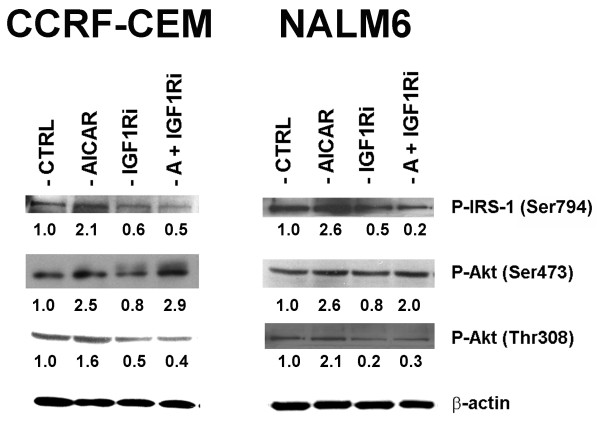
AICAR-induced AMPK activation phosphorylates Akt at Ser473 in a mechanism independent of IGF-1R/IRS-1 signaling in ALL cell lines. Western blot analysis of P-IRS-1 (Ser794), P-Akt (Ser473), and P-Akt (Thr308) in CCRF-CEM and NALM6 cells treated with 0.1% DMSO (CTRL), AICAR (200 μM), the IGF-1R tyrosine kinase inhibitor HNMPA(AM)3 (IGF1Ri, 10 μM), or both agents (A + IGF1Ri) and incubated for 24 h at 37°C. The levels of P-IRS-1 and P-Akt were normalized to β-actin (loading control) and expressed relative to control (shown as fold induction).